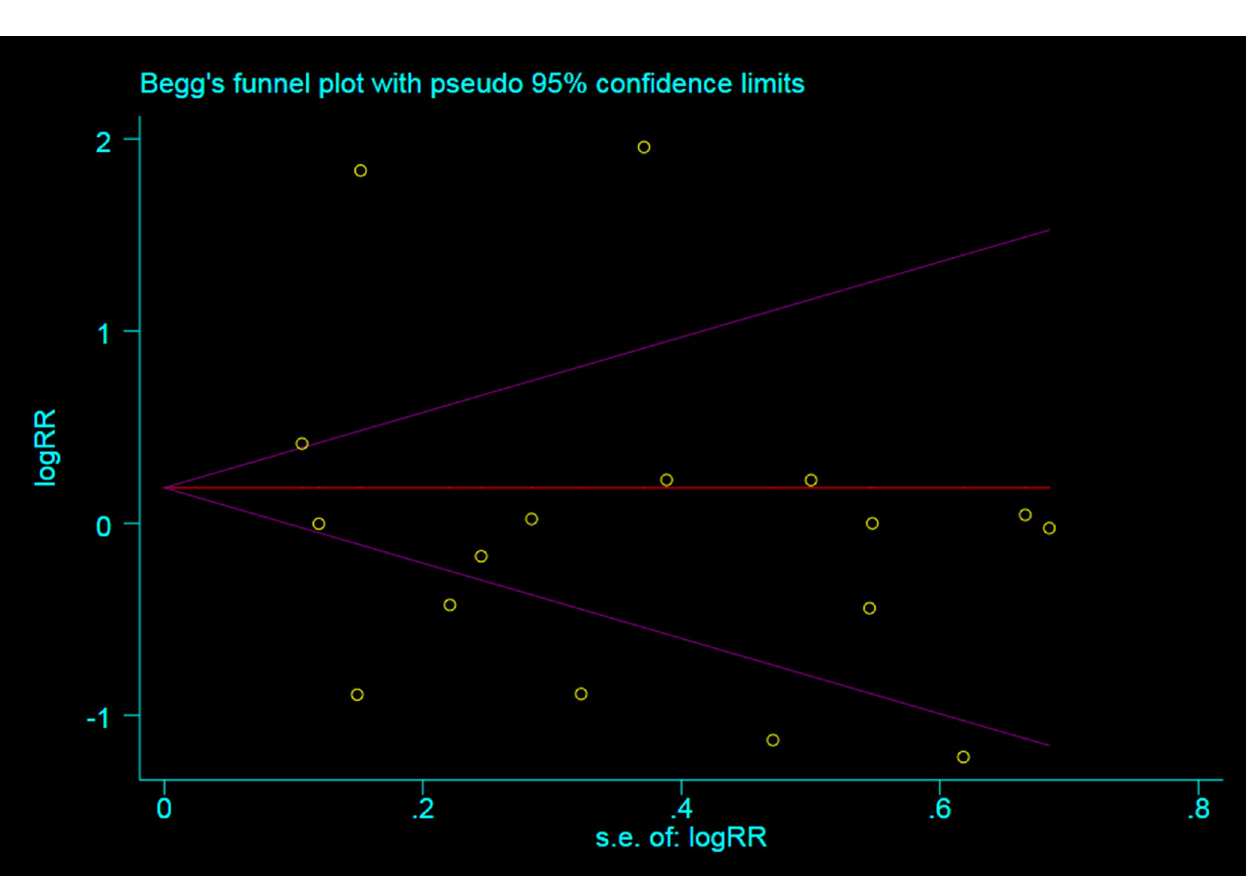
Fig 3. Funnel plot of insertion success for publication bias